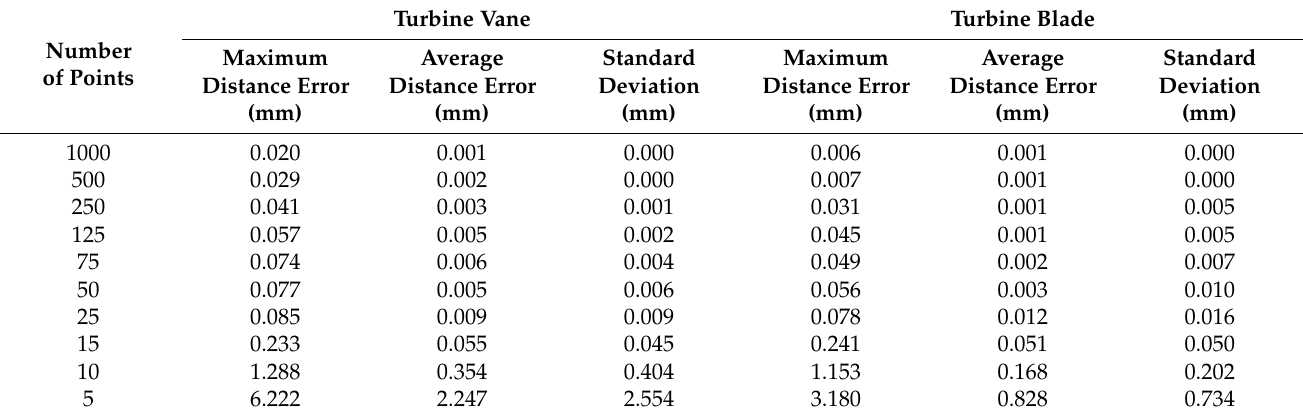
Table 1. Comparison of distance error after simplifying number of knots for the CMM